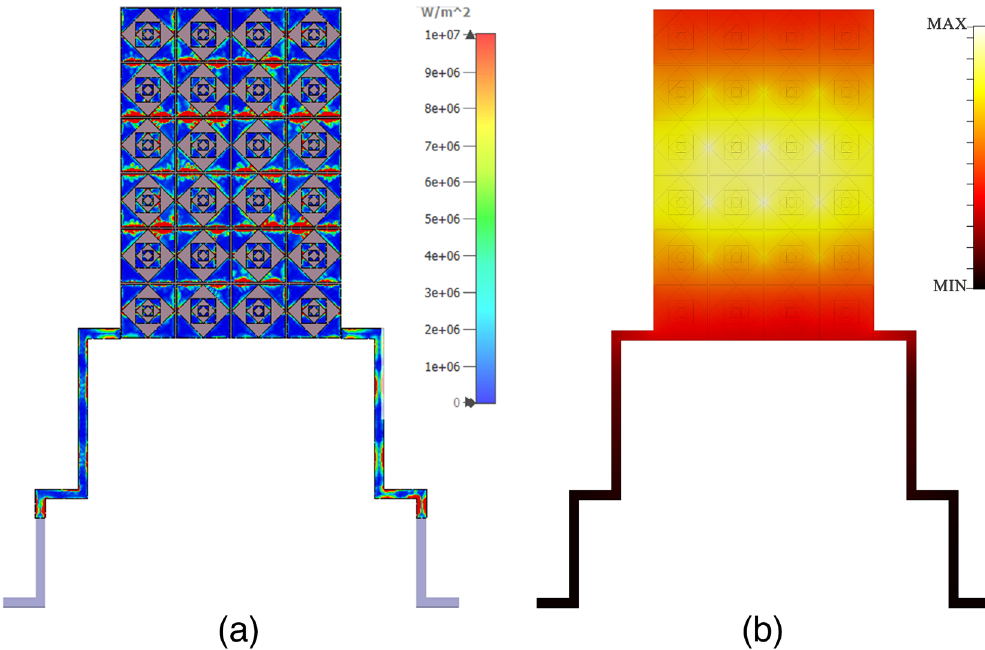
Figure 7. ( a ) Surface power loss density of the FMMA based focal plane array (FPA) for mode-4, ( b ) Thermal density distribution at mode-4. The figure was edited using Adobe Photoshop CC 2022 (Version 23.4.1, https:// www. adobe. com/ produ cts/ photo